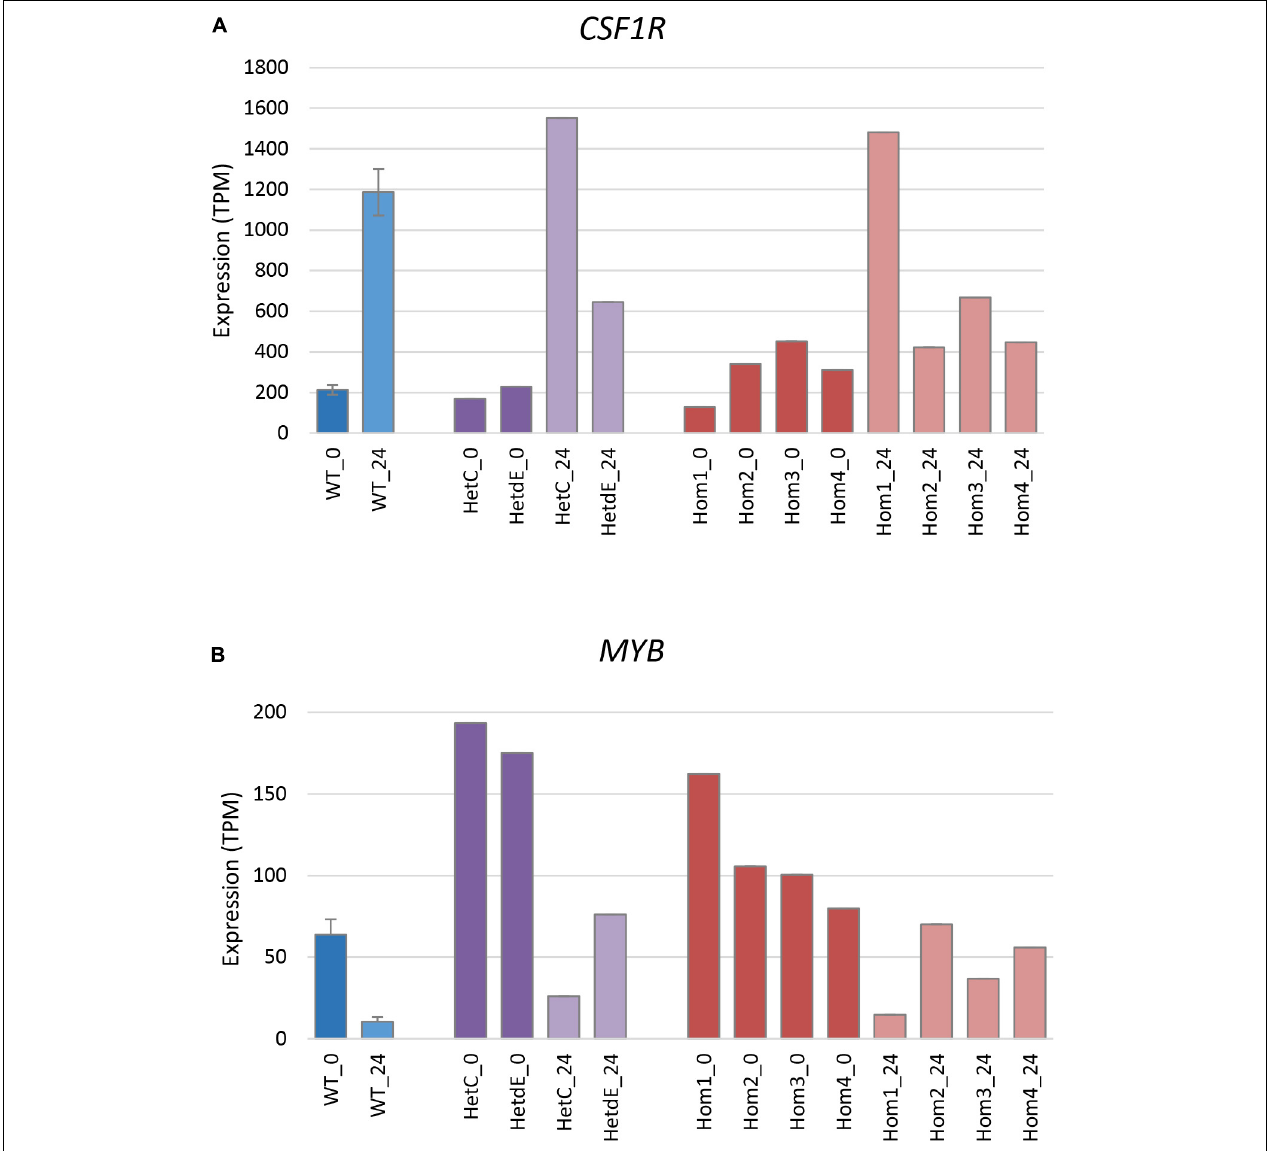
FIGURE 5 | Expression of signature genes in edited clones. Results are based on expression levels extracted from CAGE data. Wild type samples are from Gazova et al. (2020); results are the mean of 6 (0 time point) and 4 (24 h time point) replicates and standard error is shown by the bars. ( A ) Expression of CSF1R (total of three promoters), a marker of monocyte to macrophage transition. At 0 h, Hom1 was significantly lower than wild type ( p = 0.0006) while at 24 h it was significantly higher ( p = 0.01). The mean value for Hom2-4 was slightly higher than wild type at 0 h ( p = 0.04) but did not change after PMA stimulation and was then significantly lower than wild type ( p = 0.005). ( B ) Expression of MYB (total of two promoters), a marker of cell proliferation. At 0 h, Hom1 was significantly higher than wild type ( p = 0) while at 24 h it was not significantly different ( p = 0.15). The mean value for Hom2-4 was slightly higher than wild type at both 0 and 24 h ( p = 0.04 in both